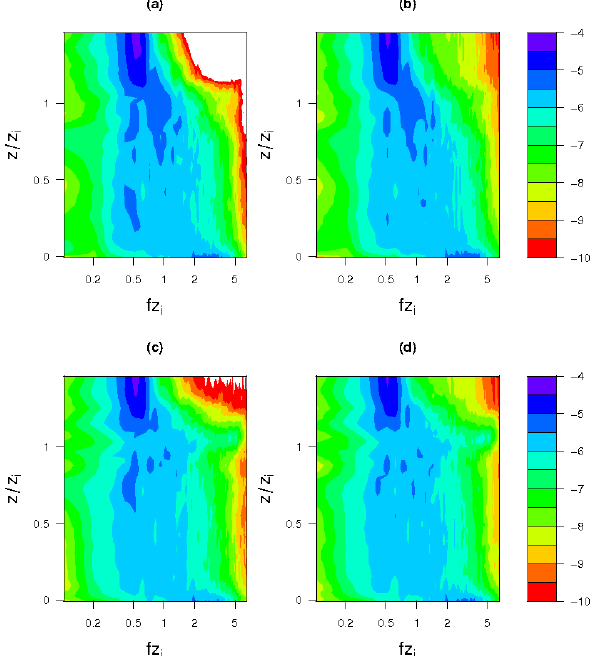
Fig. 8. Normalized copectra [Pm] for control simulation. (a) Sur- face temperature and air temperature (b) surface sensible heat and air temperature (c) soil moisture and air specific humidity (d) sur- face latent heat and specific